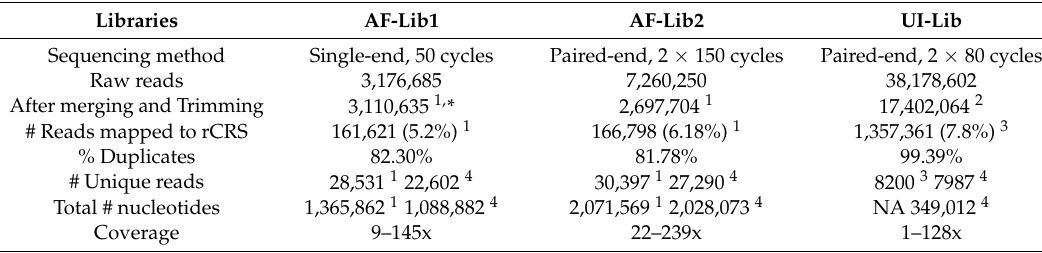
Table 1. Sequencing statistics and description of the programs used in this